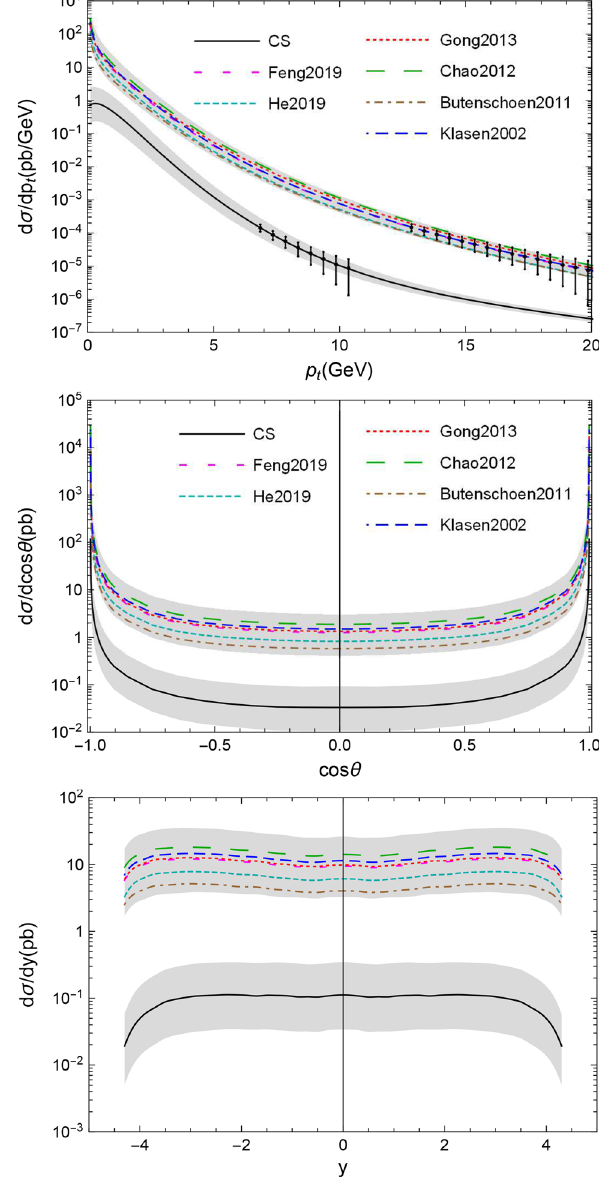
Fig. 1 The p t (upper), cos θ (mid), and y (lower) distribution of prompt J /ψ employing different CO LDMEs in Table 1. The y plots use same legends as p t . The light gray bands represent the theoretical uncertain- ties from μ r and μ f dependence, and the vertical lines in the p t distri- bution plot show the statistic error estimated from our simple detector simulation. Here only the uncertainties for the CO LDMEs of Feng 2019 are shown